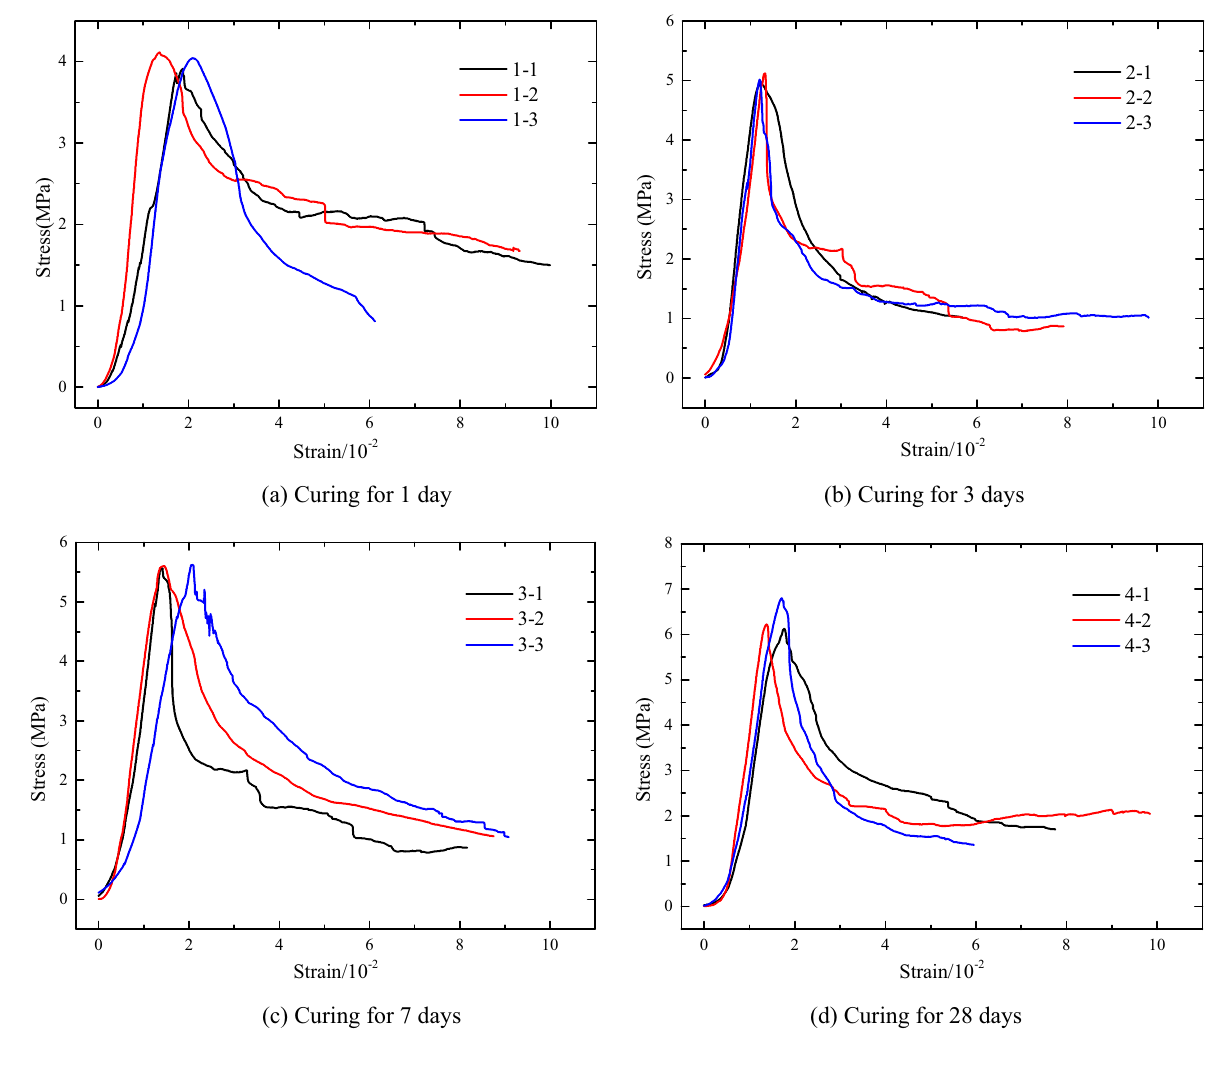
Fig. 7 Strength curves of high-water material for different curing ages